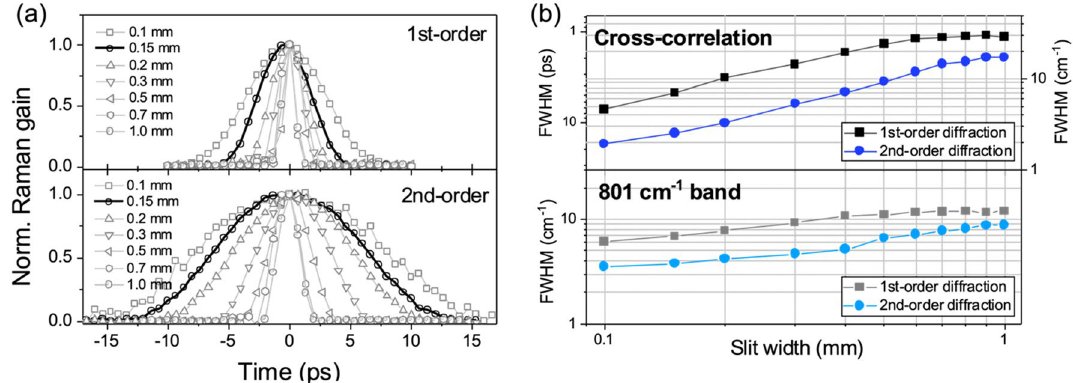
Figure 4. ( a ) The cross-correlation widths of stimulated Raman signal at 801 cm −1 of cyclohexane are shown as a function of the slit width in the DPGF setup with the 1st- (upper panel) and 2nd-order diffraction (lower panel). ( b ) FWHM values of cross-correlation signal fitted by Gaussian function are represented by using the 1st- (upper, the black squared line) and 2nd-order diffraction (upper, the blue dotted line) in temporal domain with varying the slit width. Calculated FWHM in the frequency domain by the relation of ṽ = 1/cT (c = the speed of light; T = temporal width). The experimentally measured FWHM of 801 cm −1 Raman band fitted by Voigt function is plotted versus the slit width with the 1st- (lower, the gray squared line) and 2nd-order (lower, the sky-blue dotted line) diffraction methods.